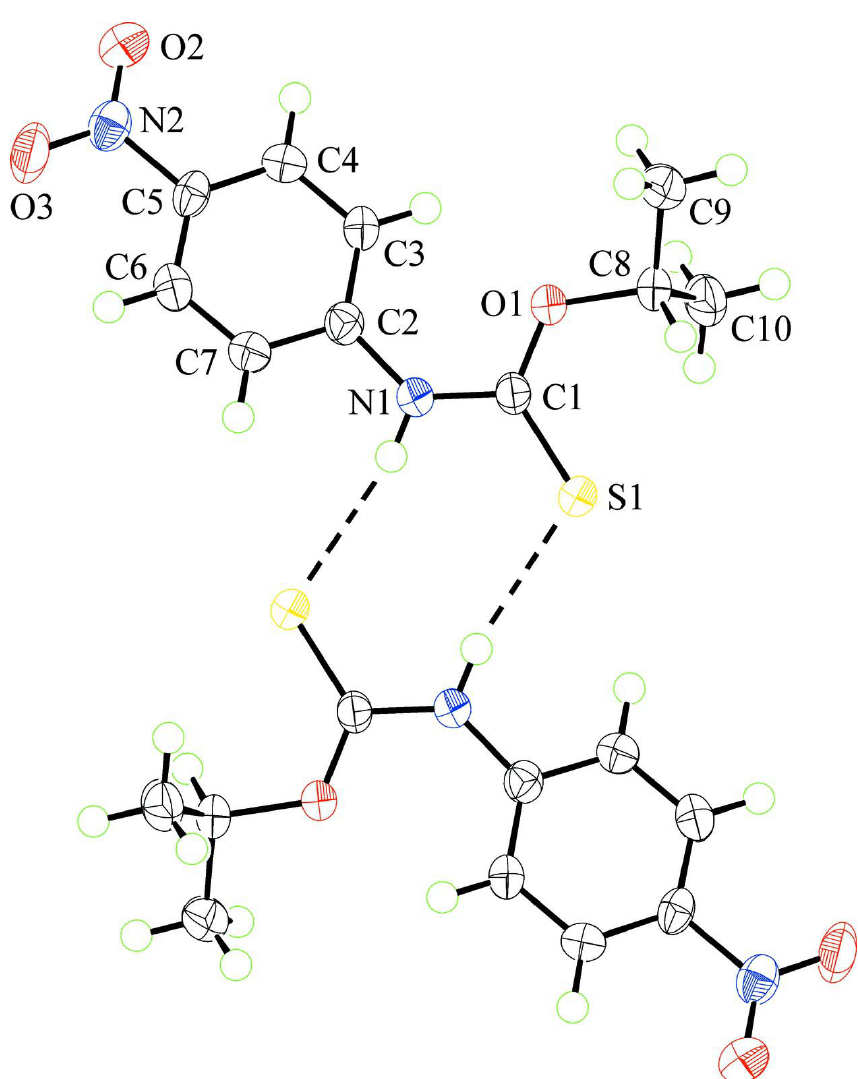
Figure 1 Dimer formation in (I) mediated by N—H···S hydrogen bonding (dashed lines) between the centrosymmetrically related molecules, showing atom labelling and displacement ellipsoids at the 70% probability level. The unlabelled atoms are related to the labelled atoms by 1 - x , - y , - z